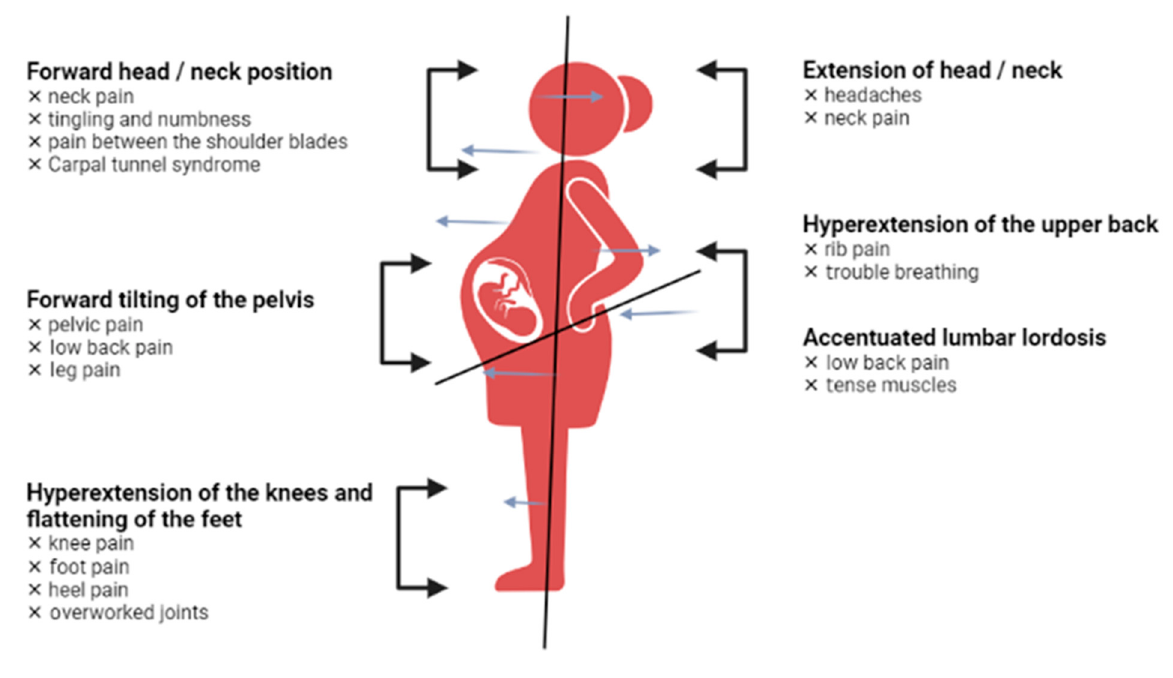
Figure 2. Postural changes in pregnant women.